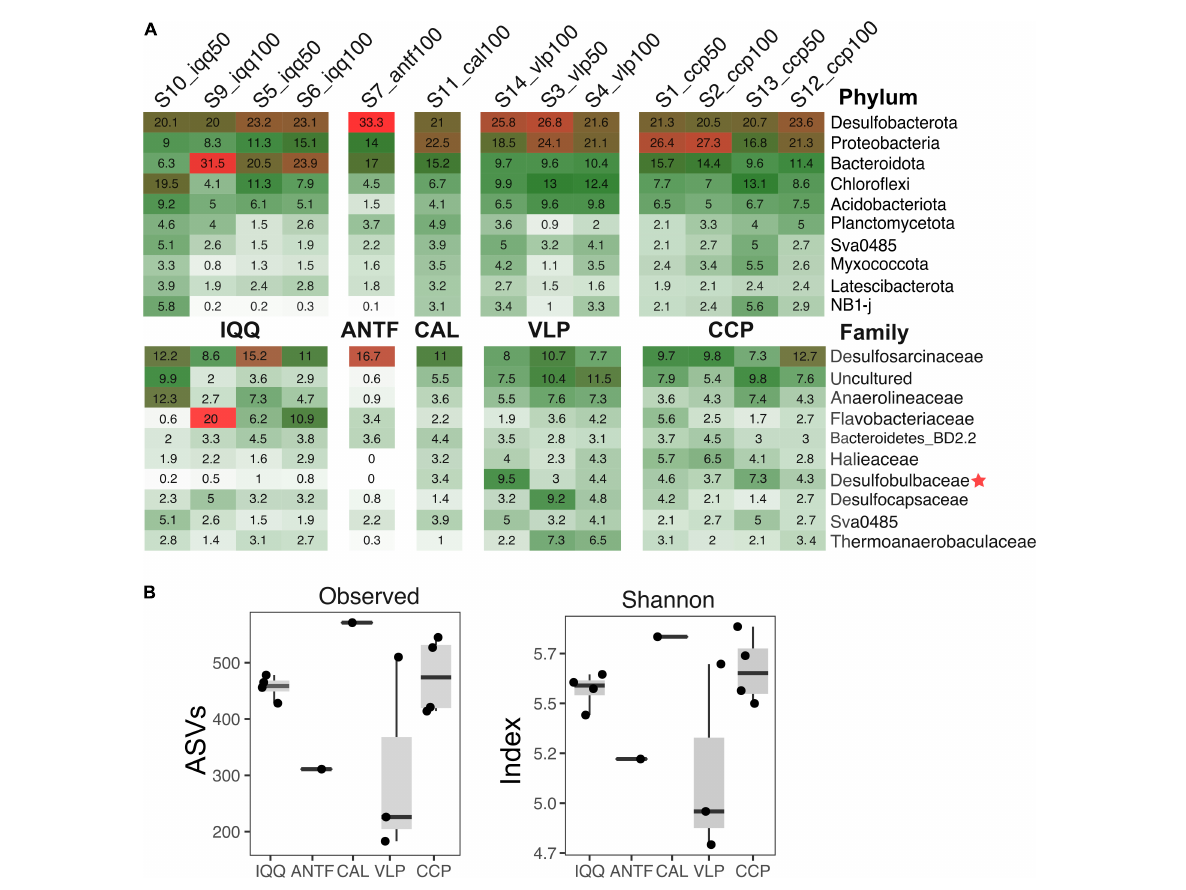
FIGURE2 (A) Abundance of the ten most abundant phyla and families. The numbers in tiles represent the relative abundance in percent. The red star highlights taxa with statistically significant differences in abundance according to Aldex 2. (B) Number of observed ASVs and Shannon diversity